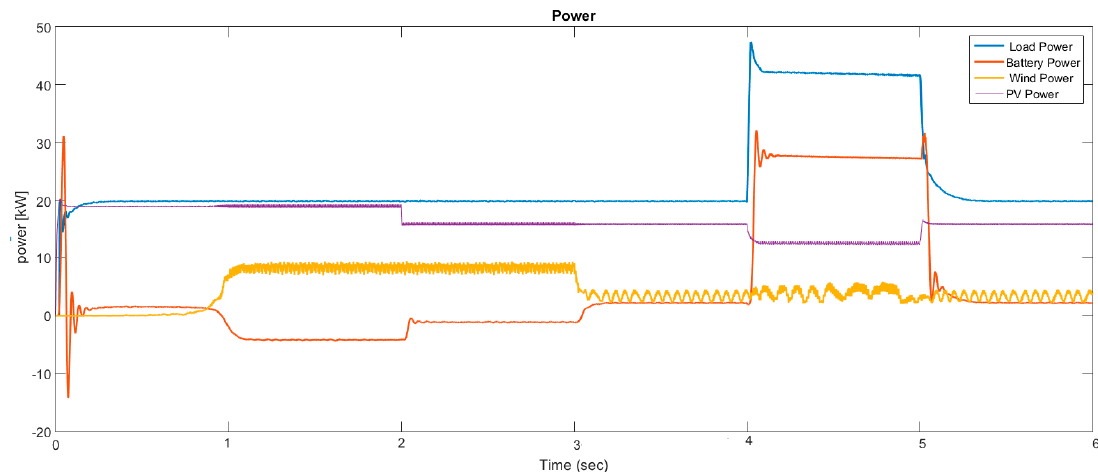
ff erent power values for sources and Figure 22. Different power values for sources and loads. Figure 22. Di Figure 22. Different power values for sources and loads. Figure 22. Different power values for sources and loads.